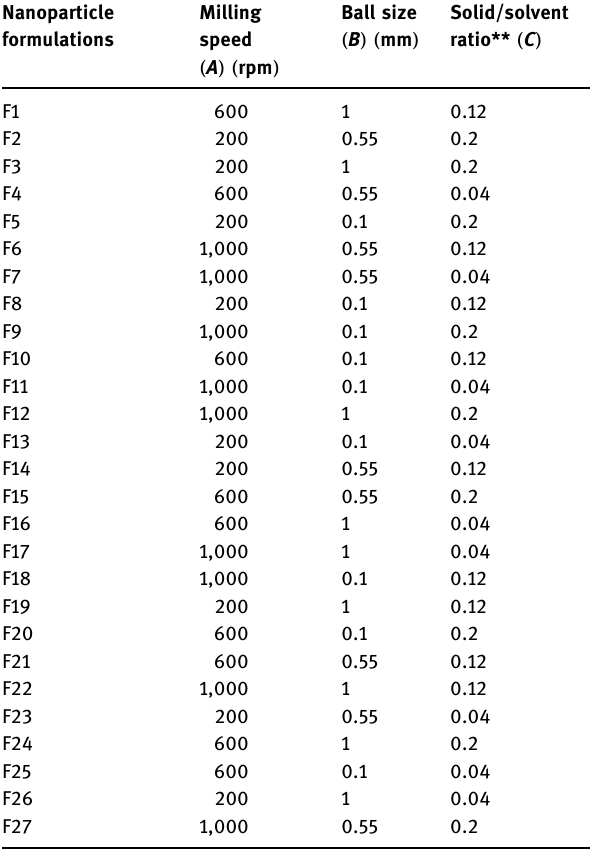
Table 2: Matrix of 3³ full factorial design for APG